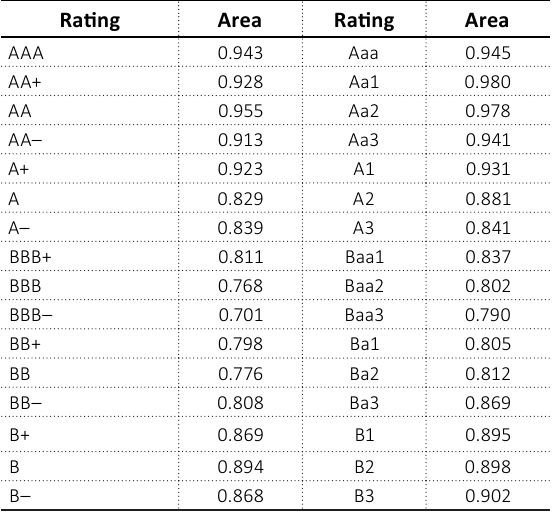
Table 15. Area under the ROC curve for each rating